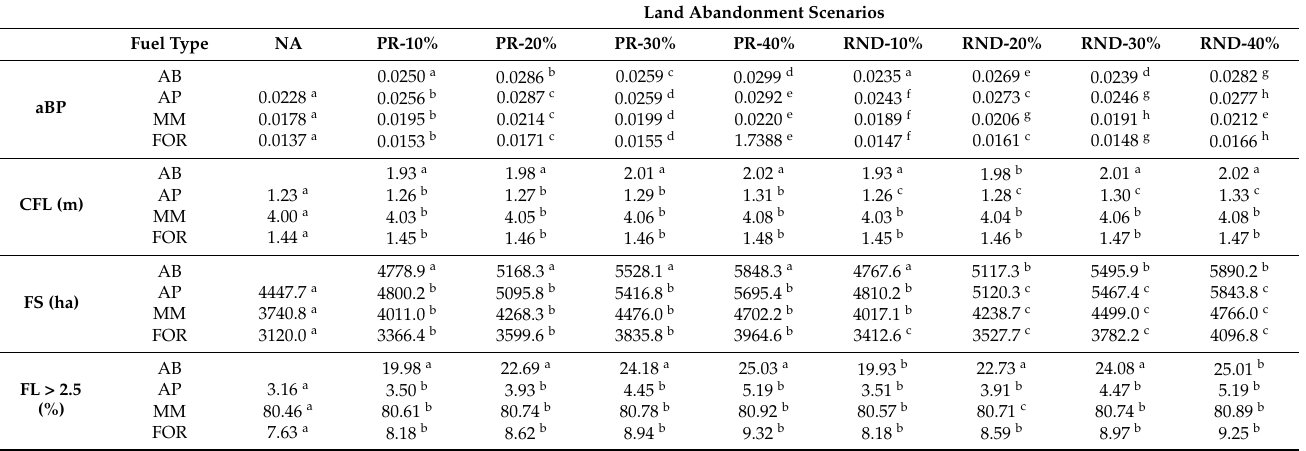
Table 3. Summary of annual burn probability (aBP), average conditional flame length (CFL, in m), average fire size (FS, in ha) and percentage of land with FL > 2.5 m (FL > 2.5 m, in %) for the main fuel types (AB, abandoned lands; AP, agropastoral vegetation; MM, Mediterranean maquis; FOR, forests) of the study area, considering the NA conditions and two spatial patterns of land abandonment scheme 10, 20, 30, and 40% of agropastoral land abandonment). The significance of the statistical differences among scenarios, for each wildfire hazard indicator, was evaluated by the Kruskal–Wallis test and the Bonferroni post hoc test for pairwise